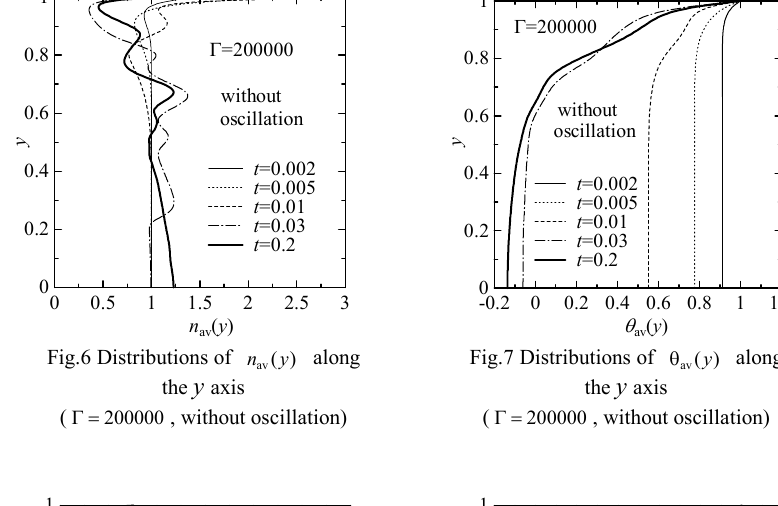
Fig.7 Distributions of along the y axis